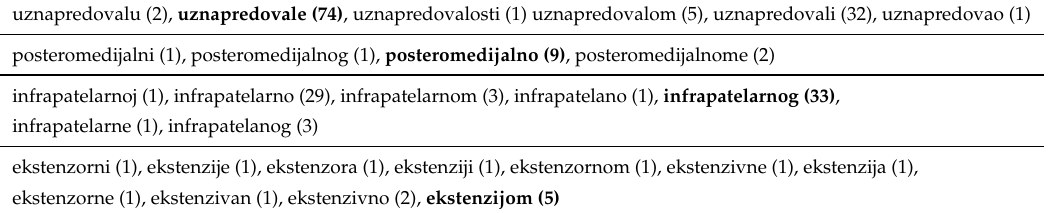
Table 3. Examples of morphological clusters obtained via our simple heuristic word clustering algorithm. The numbers in brackets indicate the number of occurrences in our corpus of radiology reports. Selected lemma of each cluster is